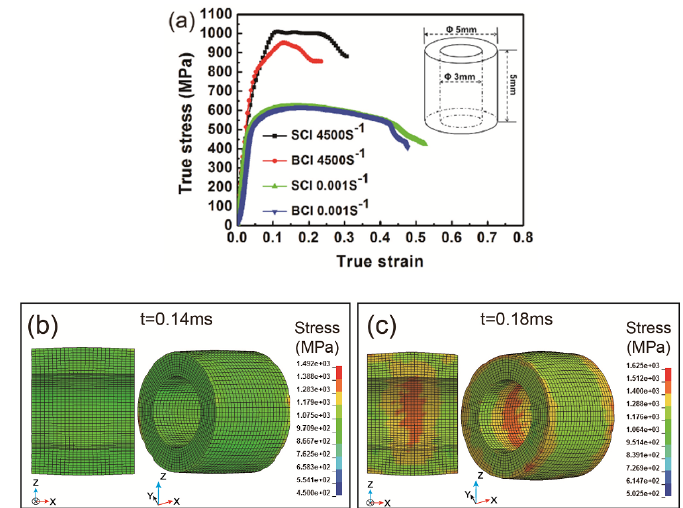
Figure 5. Mechanical performance and finite element modelling under compressive tests for W-30Cu composites at room temperature: ( a ) true stress–strain curve; ( b ) stress distribution at 0.14 ms; ( c ) stress distribution at 0.18 ms.